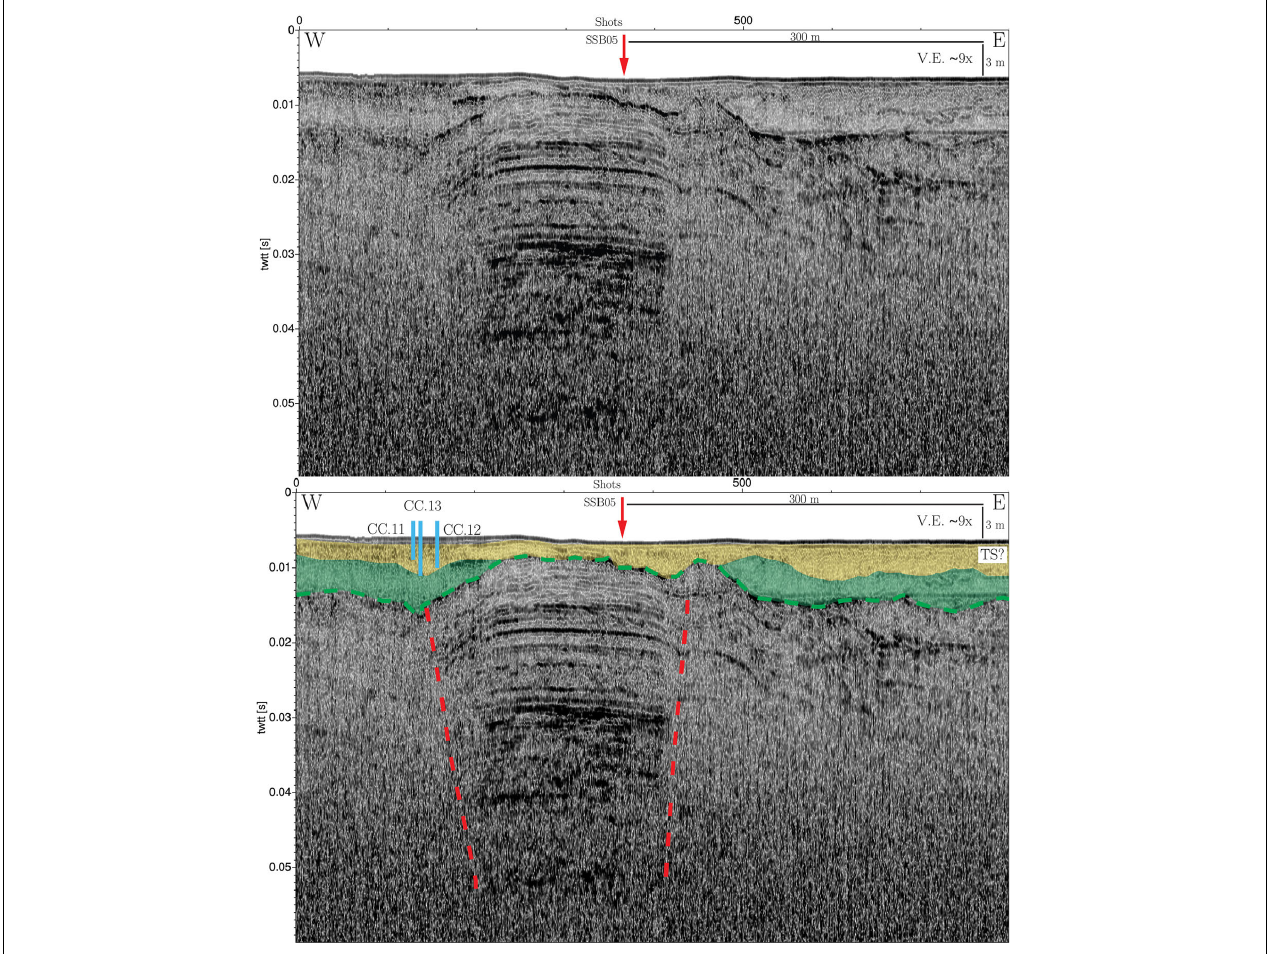
FIGURE 10 | Chirp profile SSB02 with core correlation in the Crown Cove area. Red dashed lines are faults forming a potential pop-up structure. Green dashed horizon is the interpreted subaerially exposed surface from the Last Glacial Maximum sea level low-stand. Green unit represents deposition from the last sea level low-stand until inundation (transgressive deposit) and yellow unit represents estuarine/marine deposition following inundation of the bay (high-stand deposit) (TS, Transgressive Surface). Boundary between green and yellow units is interpreted as the transgressive / inundation surface. Red arrow marks location of north-south oriented SSB05 profile ( Figure 11 ). See Supplementary Figure 5a for